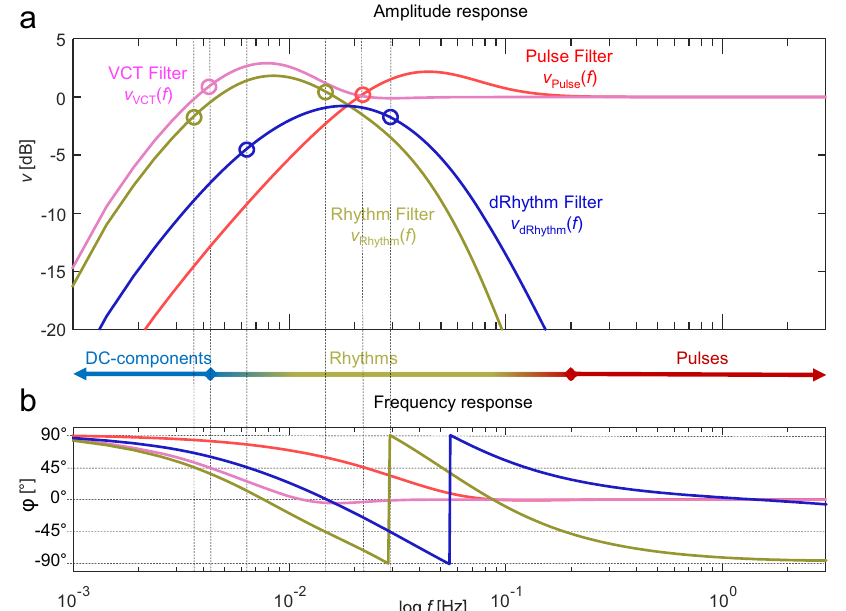
Fig. 13 Control signals in the frequency domain – Bode diagram. a The amplitude response of the volume control technique (VCT) control signals v VCT , v v v fi ltered by the VCT, pulse, rhythm, and dRhythm fi lters, respectively. In particular, DC components, pulse , Rhythm , and dRhythm . Those are light signals rhythms and pulses are discriminated. The dots and vertical lines represent the frequency cutoffs of each signal component. b Frequency response ϕ of the control signals. f :